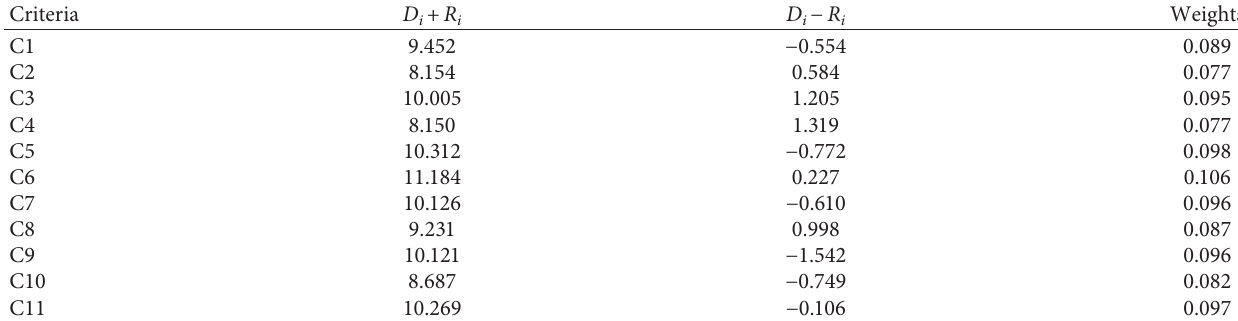
Table 18: The total influence results and weights of the criteria.